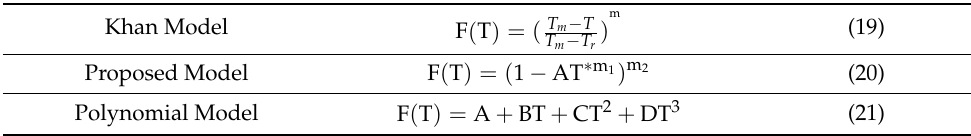
Table 5. Equations of temperature models.